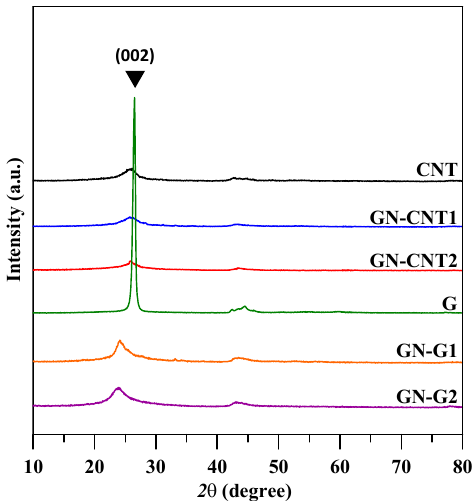
Figure 2. Typical XRD patterns of different GN samples, in which both pristine CNT and graphite (G) powders possess high crystallinity of graphite lattices. Herein, the d 002 -interlayer spacing distances are up to 3.82 Å (GN–G1), 3.85 Å (GN–G2), 3.43 Å (GN–CNT1), and 3.46 Å (GN–CNT2), as compared to the pristine carbon samples.